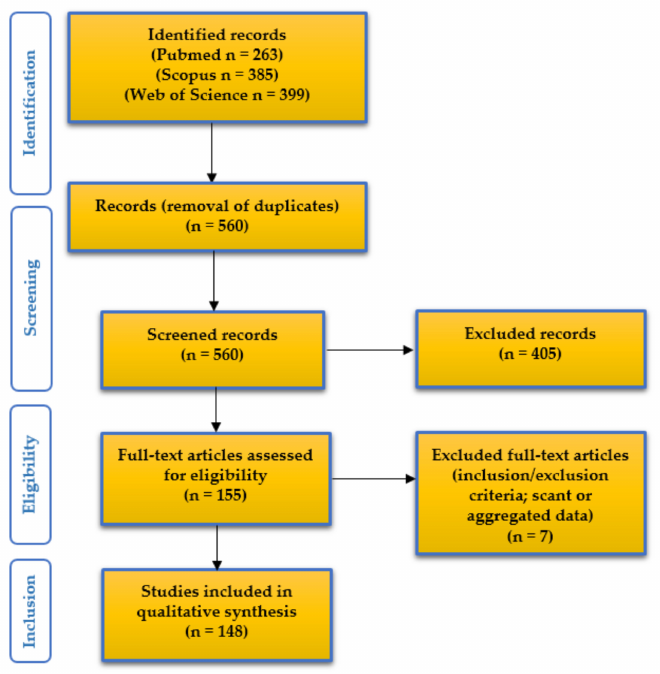
Figure 1. Review of the literature: PRISMA